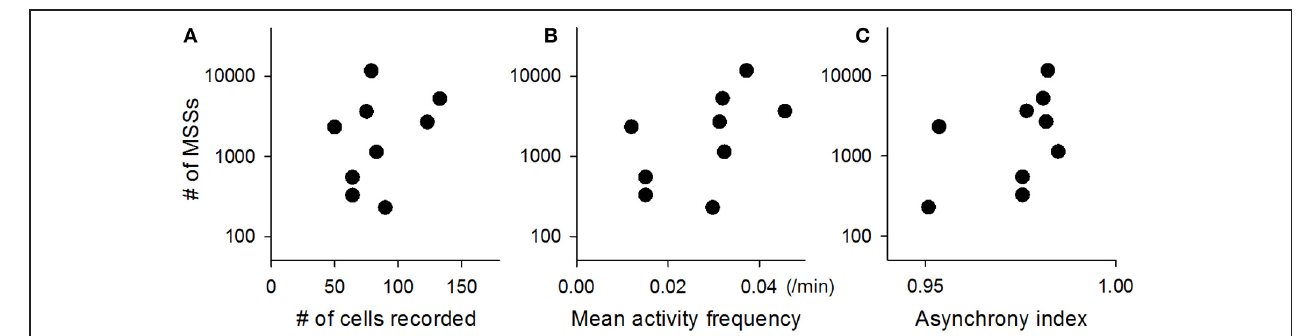
FIGURE 4 | Across-video variations of the number of MSSs. The total number of MSSs varied among datasets and thus is plotted against the total number of neurons recorded in the corresponding videos (A) , the